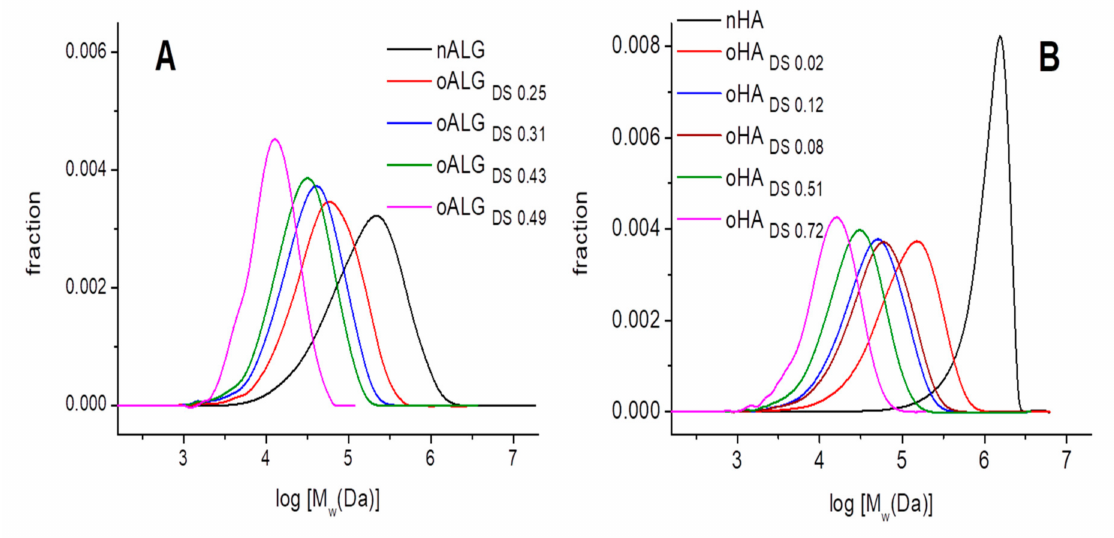
Figure 3. Molecular weight distribution of native and oxidized derivatives of ( A ) alginate and ( B ) hyaluronic acid as determined by gel permeation chromatography